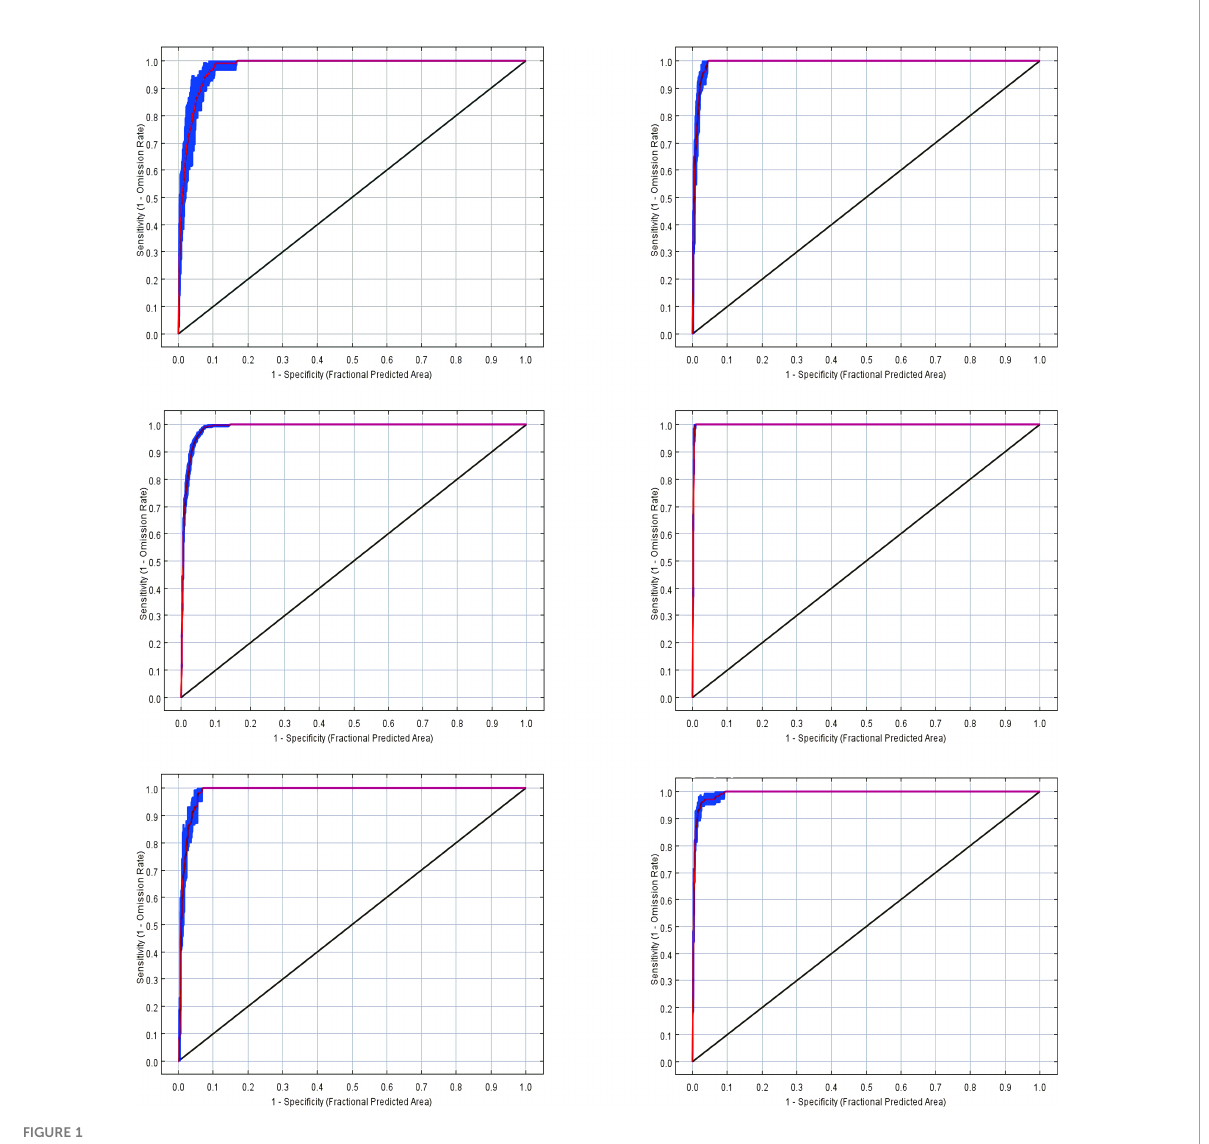
FIGURE 1 Occurrence records of six ephemeral